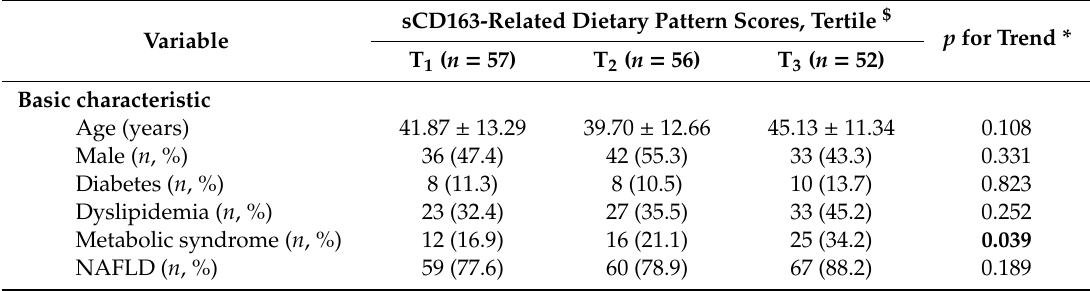
Table 4. Characteristics of the study population according to tertiles of dietary pattern scores.